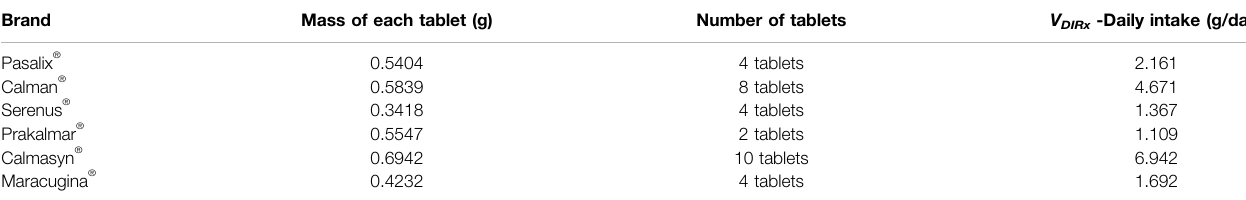
TABLE 4 | Brand of herbal medicines, mass (g) of each tablet, number of tablets and daily intake according to the package insert. Brand Mass of each tablet (g)